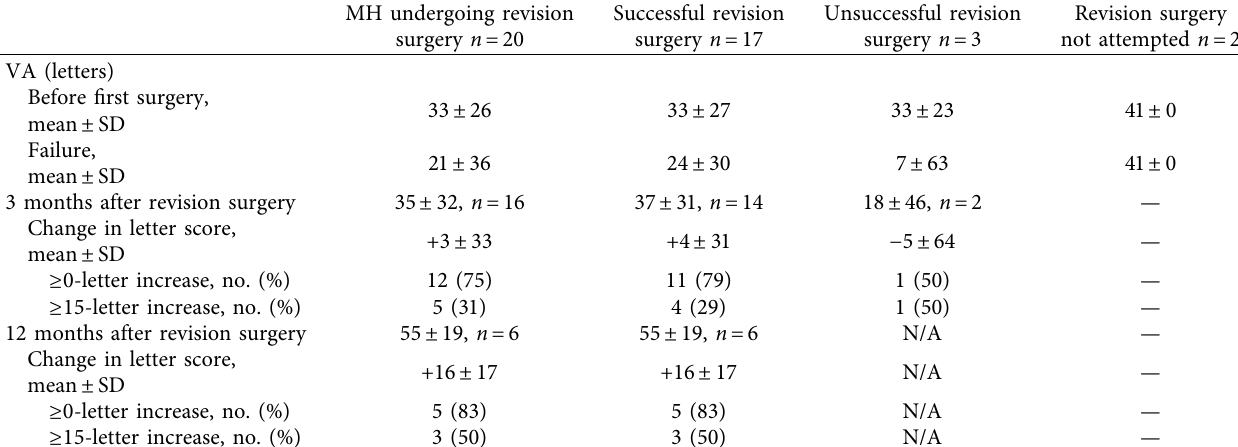
Table 3: VA after revision